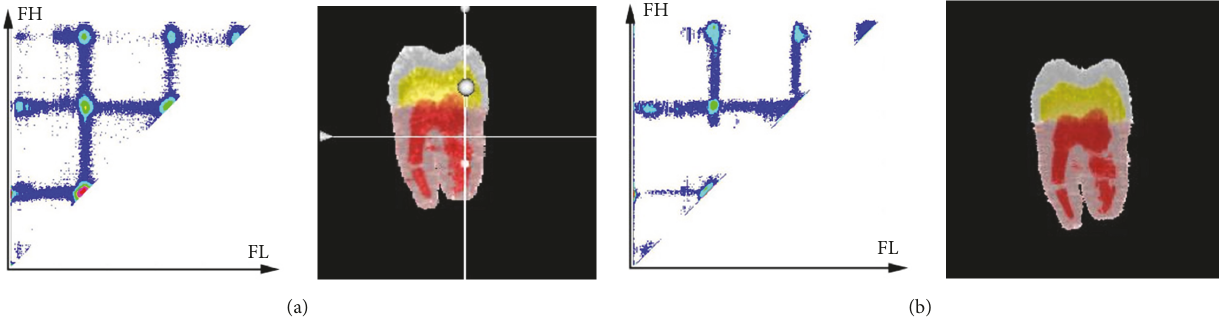
Figure 3: LH histogram and rendering result of the original tooth data and MLP denoised data: (a) LH histogram and the corresponding rendering result of original data and (b) LH histogram and corresponding rendering result of denoised data.